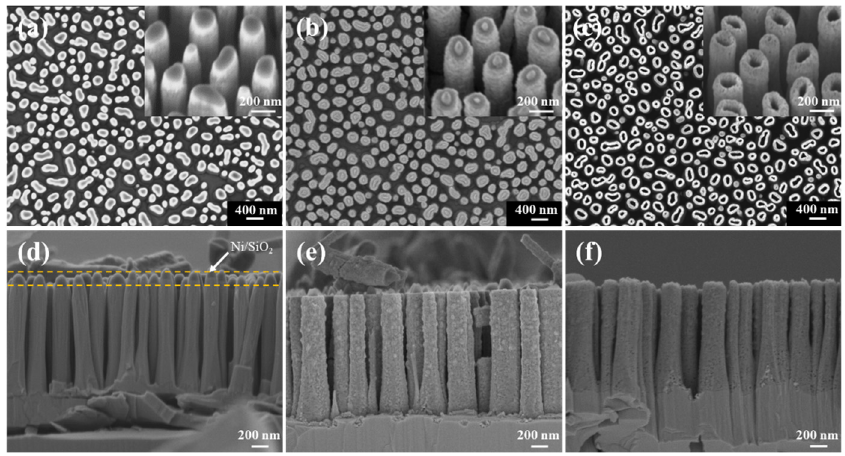
Figure 3. SEM images ( a , d ) of the GaN nanowire (NW) arrays before BOE treatment. SEM images ( b , e ) of the GaN@Ga 2 O 3 NW arrays oxidized at 950 °C for 10 min. SEM images ( c , f ) of the β -Ga 2 O 3 NT arrays after ICP etching. The inset of ( a – c ) is the tilted-view SEM image. The grazing incidence in-plane geometry was used to determine the crystal structure of Ga 2 O 3 grains. Figure 4 shows the in-plane diffraction patterns of unoxidized GaN nanowires and Ga 2 O 3 nanotubes oxidized at 950 °C for 5 min, 10 min, and 15 min. The XRD reflections at 18.9°, 30.2°, 31.7°, 35.1°, 37.4°, 60.0°, and 64.7° were assigned to the beta phase of monoclinic Ga 2 O 3 planes ( − 201), (400), (002), (111), (401), ( − 603) and ( − 712), respectively. The result indicates that GaN is converted to polycrystalline β -Ga 2 O 3 after thermal oxidation treatment.